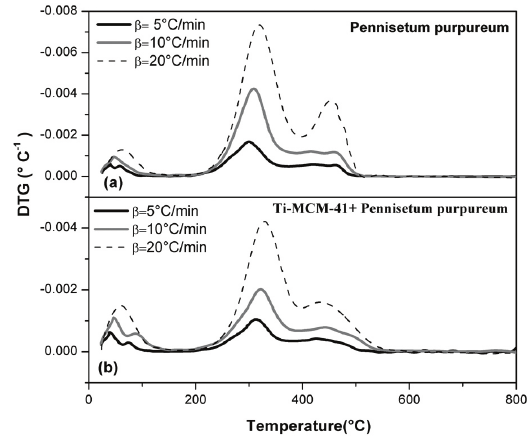
Figure 3. TG curves of Pennisetum purpureum + Ti-MCM-41 (a) and pure Pennisetum purpureum (b).